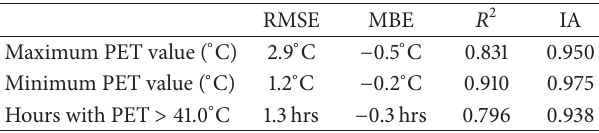
Table 3: Statistical indices for the evaluation of the forecasting abilityofthedevelopedANNno.1forecastingmodel.Onedayahead prognosis. Warm period of